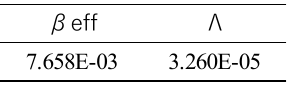
Table III. Kinetic parameter.